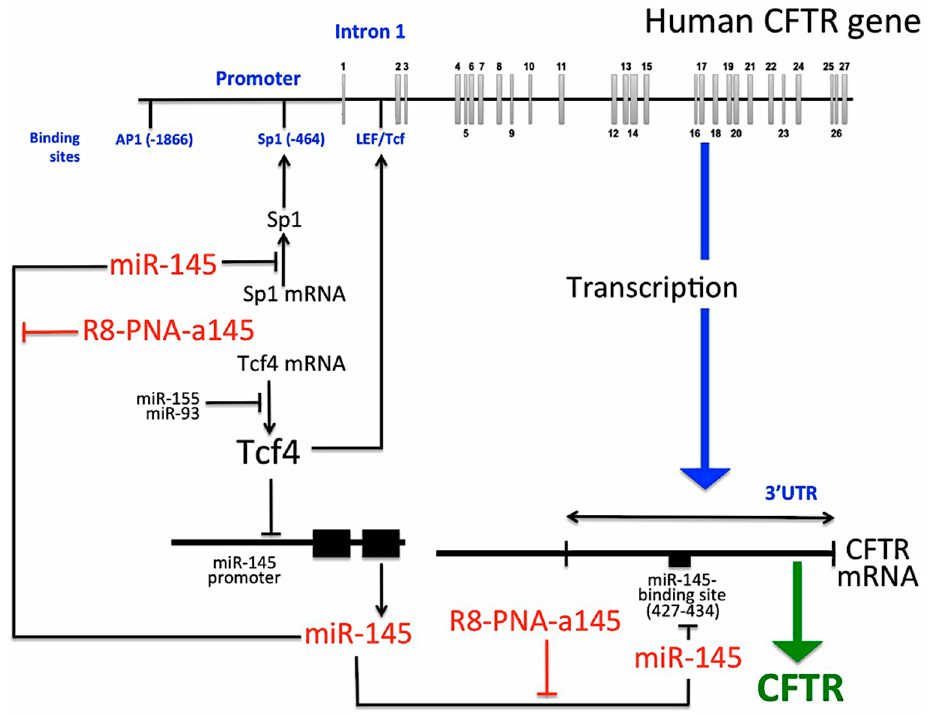
Figure 6. Proposed model for the interplay between transcription factors, CFTR regulation, miR-145-5p transcription and miR-145-5p target molecules.